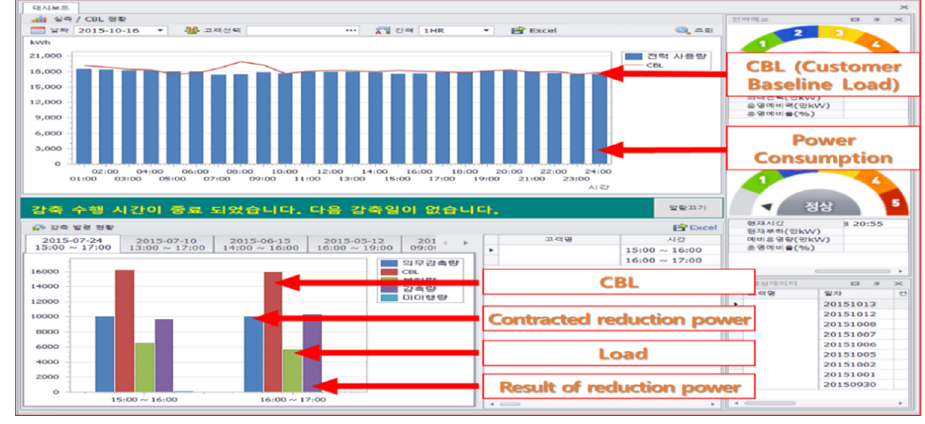
Figure 3. Dashboard of power usage.